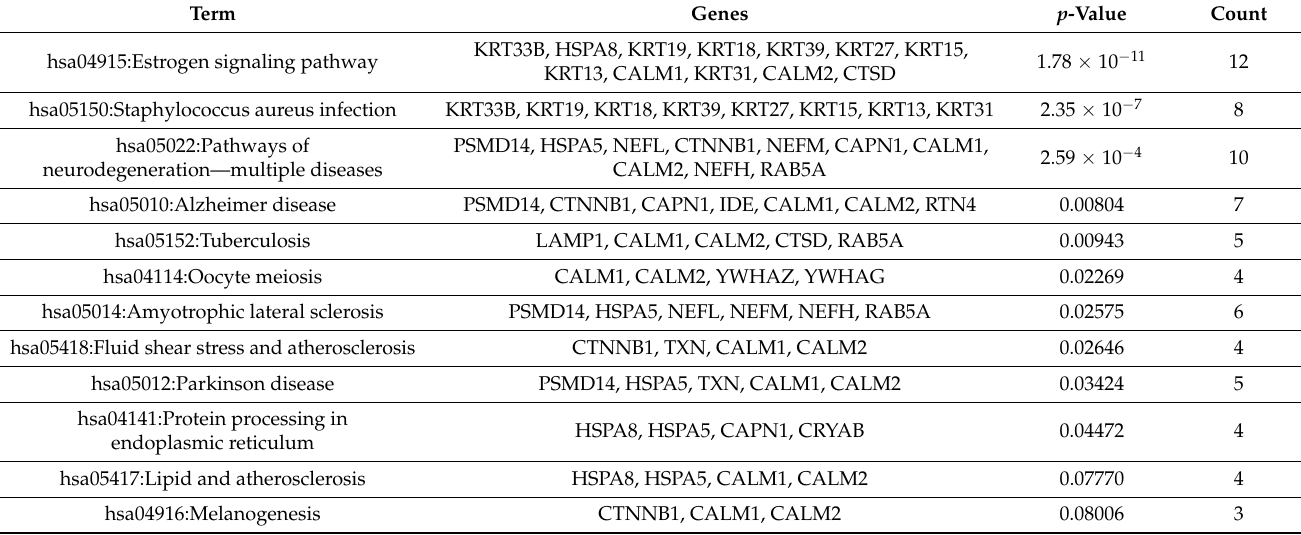
Table 1. Potential pathways, according to the KEGG database, involving interactors detected in the brain and the main proteins. Forty-nine proteins were uploaded to DAVID, and only 39 had KEGG pathway